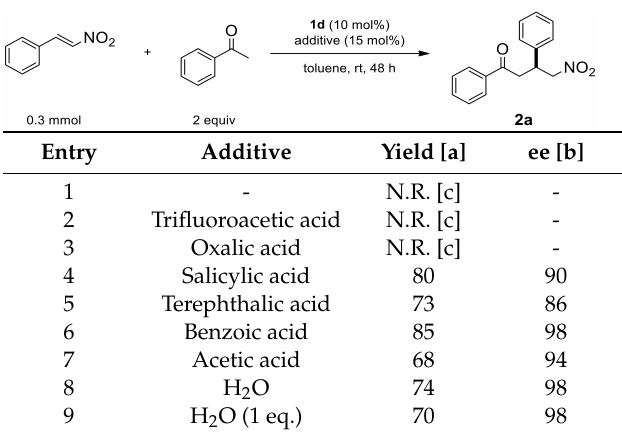
Table 3. Additive e ff ects.